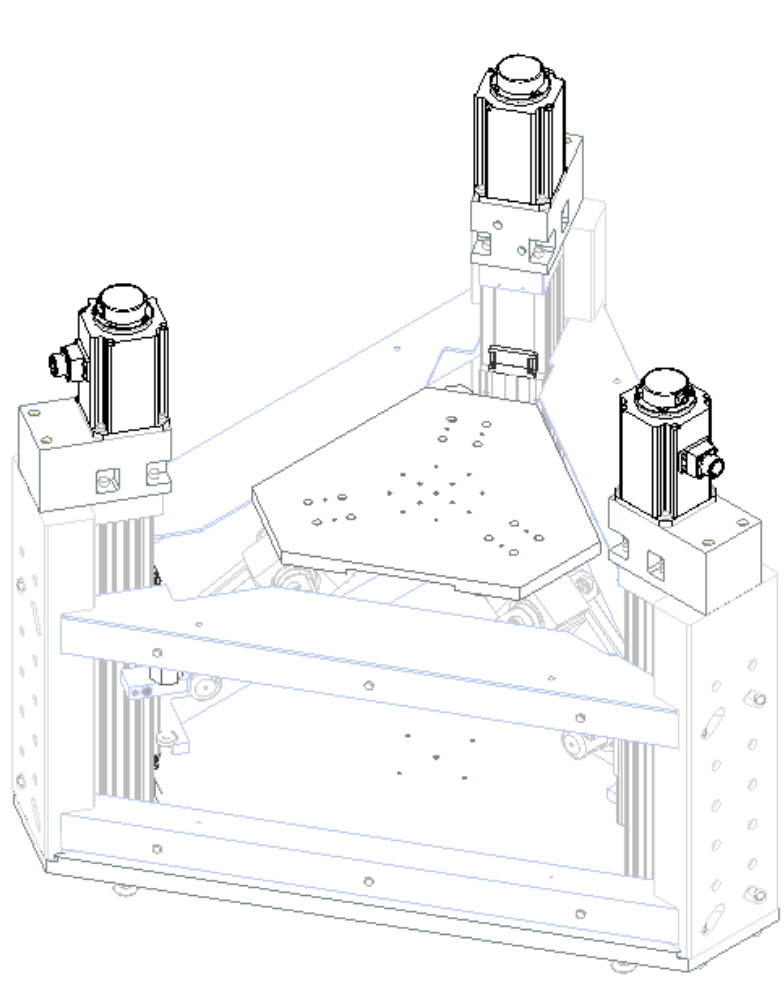
Figure 2. Drawing of the Delta Robot assembly.